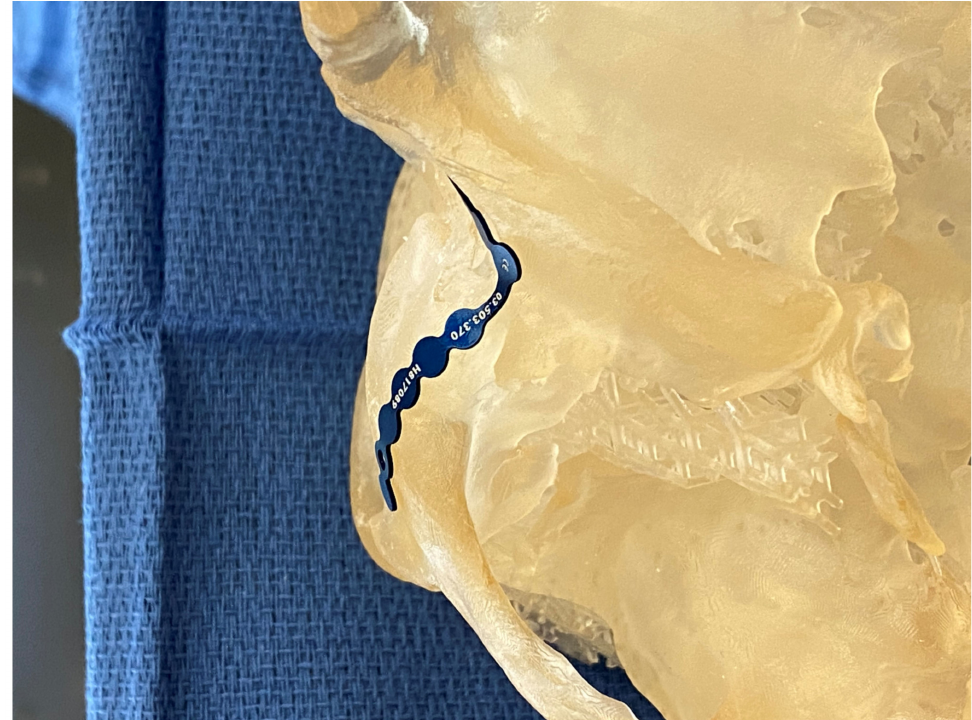
Figure 2. Template bending in preparation for plate bending on a patient-specific high-fidelity 3DP model.